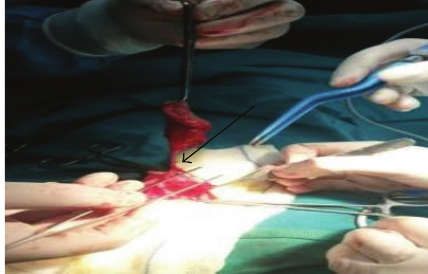
Figure 2: Demonstration of the main feeding vessel of the heman- gioma, in the deepest part of the mesoscrotal diaphragm (arrow).